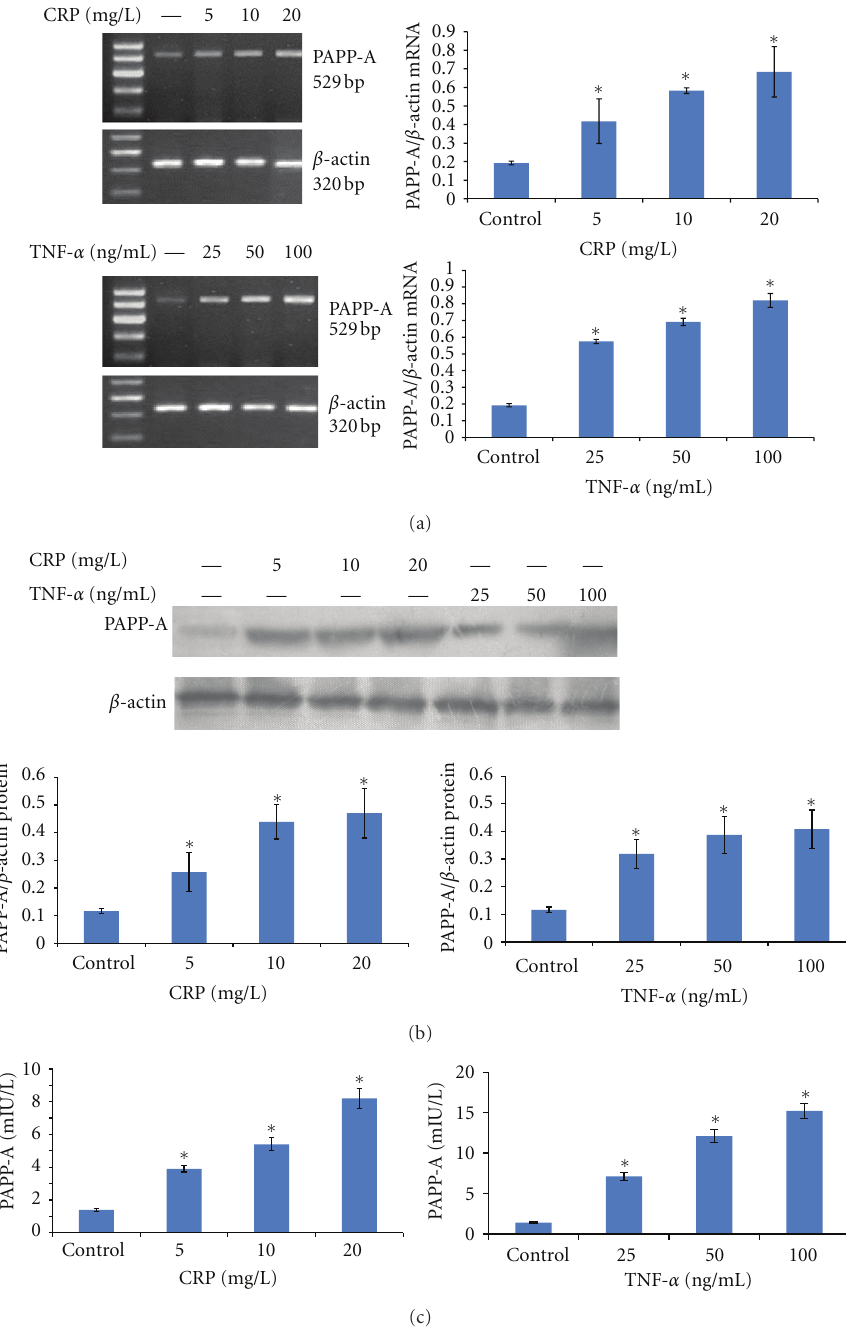
Figure 2: PBMCs were stimulated with CRP (5, 10, or 20mg/L) or TNF- α (25, 50, or 100 ng/mL) for 24 hours. (a) PAPP-A mRNA were measured using RT-PCR. (b) PAPP-A protein levels were measured by Western blotting. (c) Culture media was collected for analysis of PAPP-A concentrations by ultrasensitive ELISA. The resultant data are expressed as the means ± SD of six donors. ∗ : P < 0 . 05 compared with the